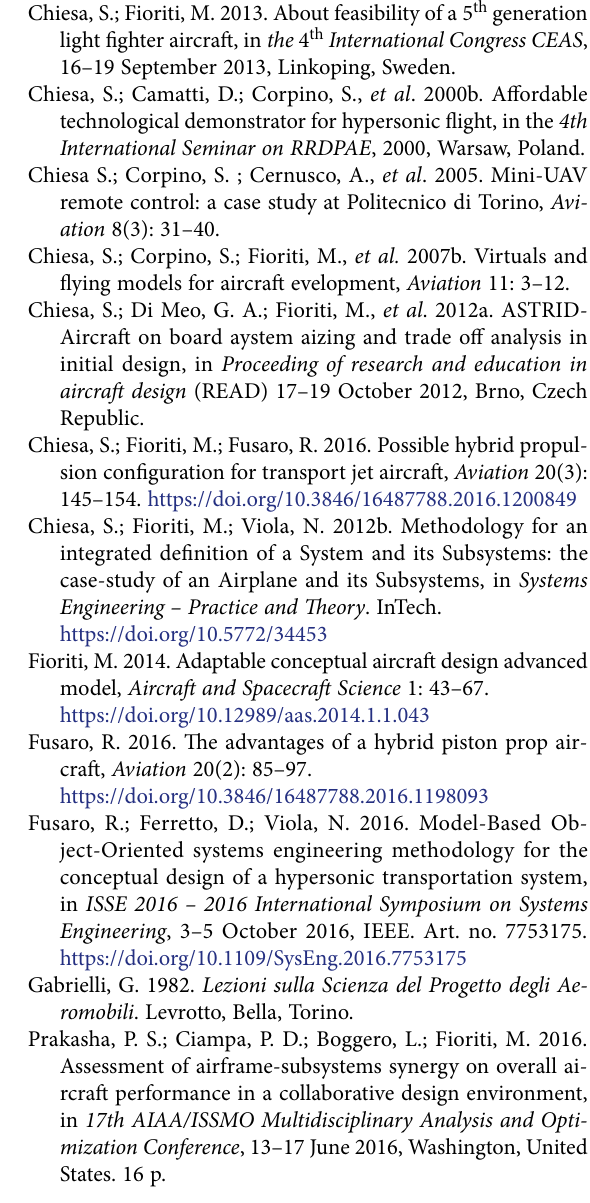
figuration at conceptual design level: a particular way for the evolution and the optimisation of the design, in the 5th European Workshop on Aircraft Design Education , 2–4 June 2002, Linkoping,